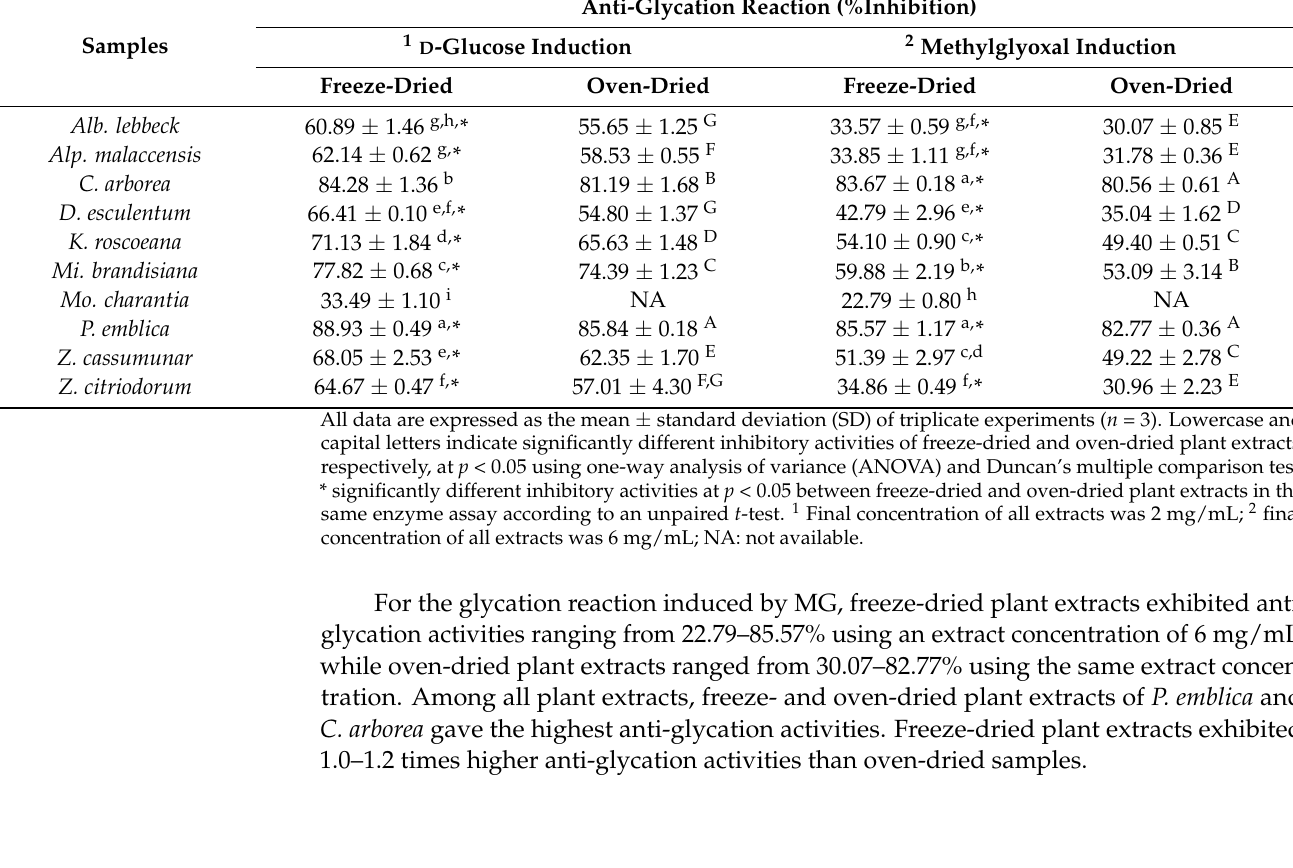
Table 6. Anti-glycation activities of 10 indigenous plant extracts prepared from freeze-drying and oven-drying